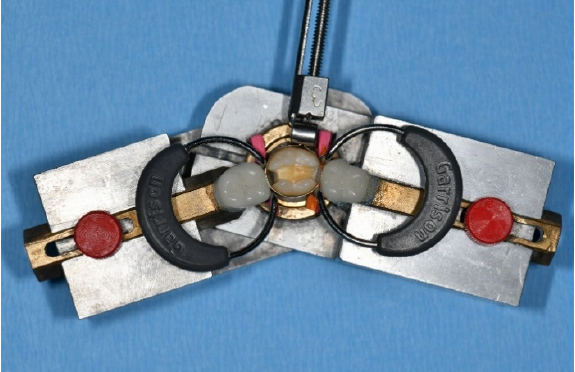
Figure 2. Artificial dental model with mounted specimen tooth, metal matrix secured in a Tofflemire holder, wooden wedges, and separation rings.